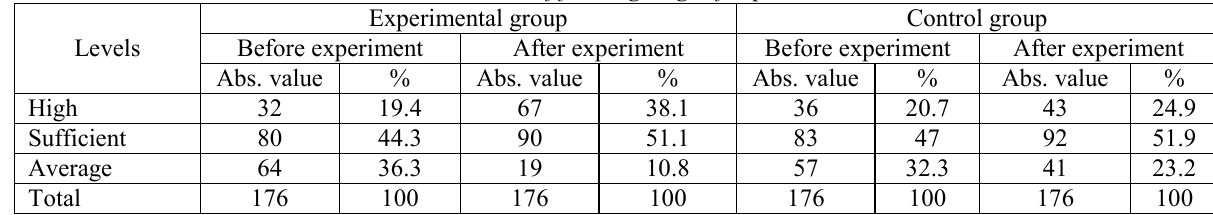
Distribution of experimental and control groups’ teachers by level of health related competence at the beginning and at the end of forming stage of